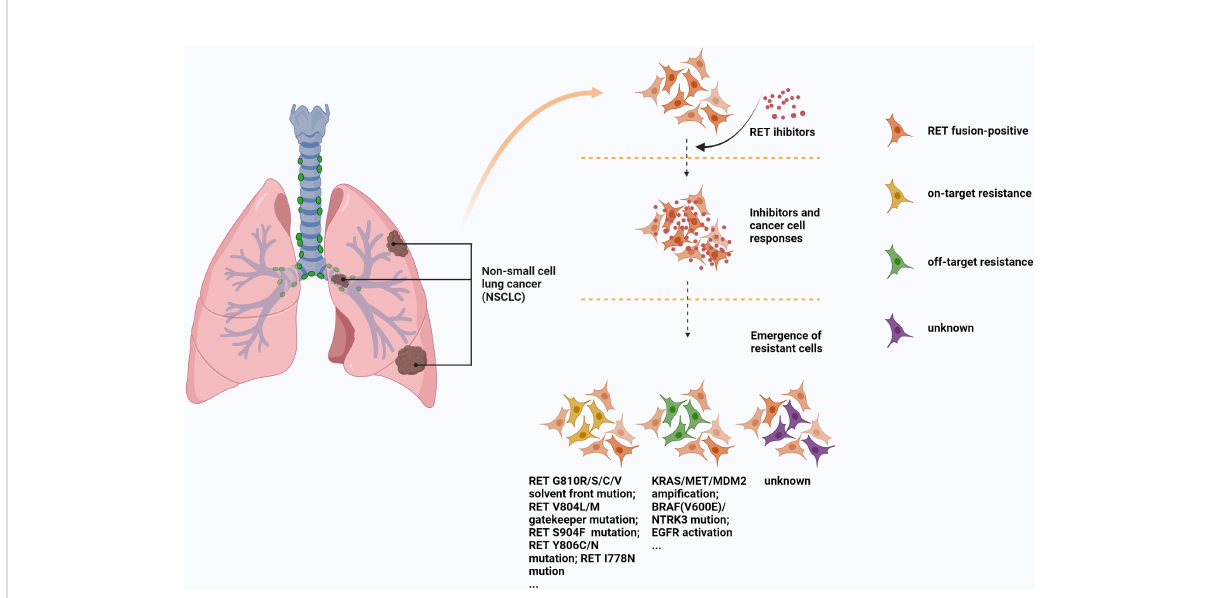
FIGURE 3 Mechanisms of MKI and TKI resistance in RET fusion-positive